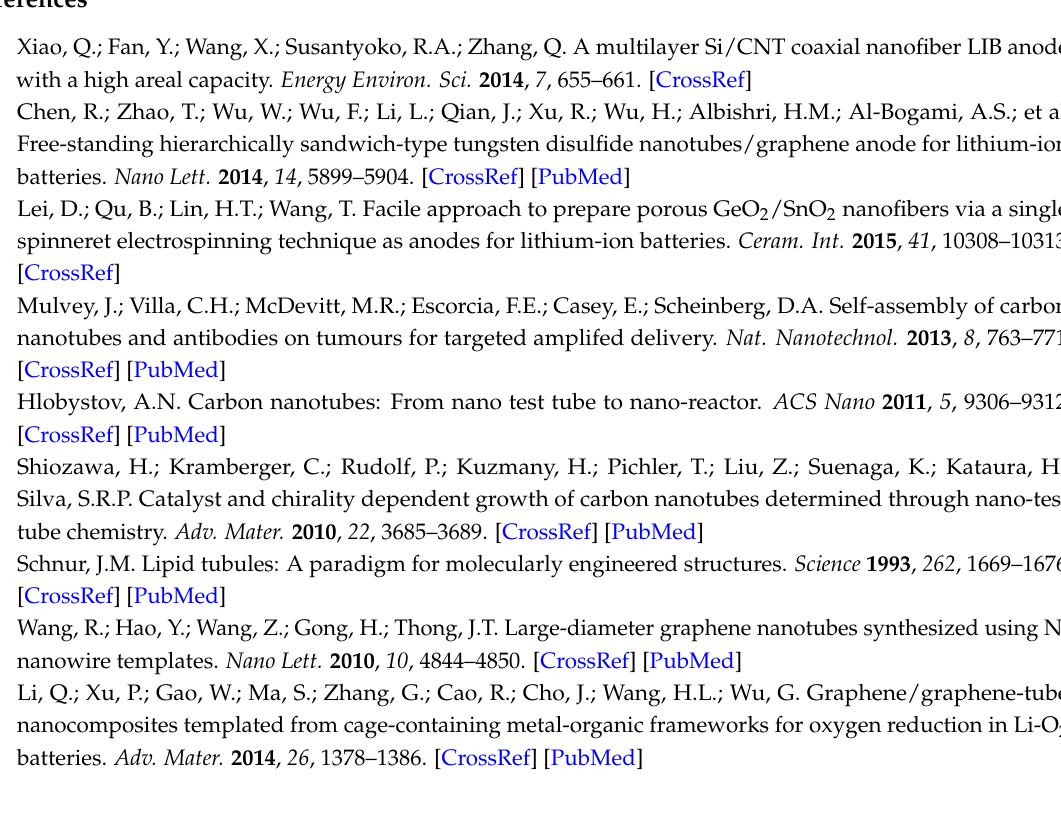
Figure S1: Transmission electron microscopy (TEM) images of the products under different ZnO dosage in 1 mL TEOS. ( a ) 0 g; ( b ) 0.05 g; ( c ) 0.1 g; ( d ) scanning electron microscopy (SEM) image of the precursor fibers when the ZnO dosage was 0.15